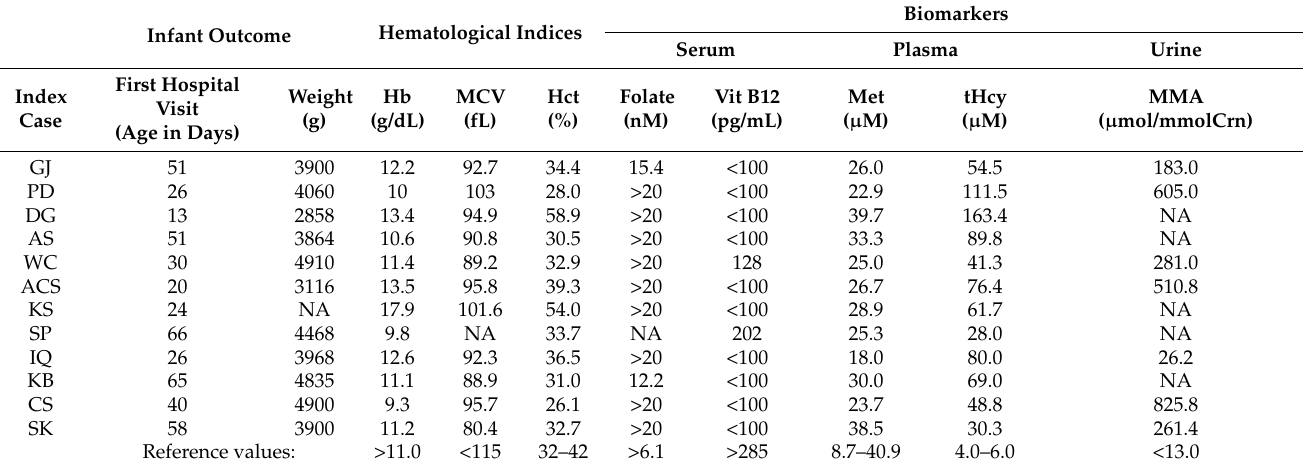
Table 2. Infant outcomes and evaluated biomarkers at first hospital visit.